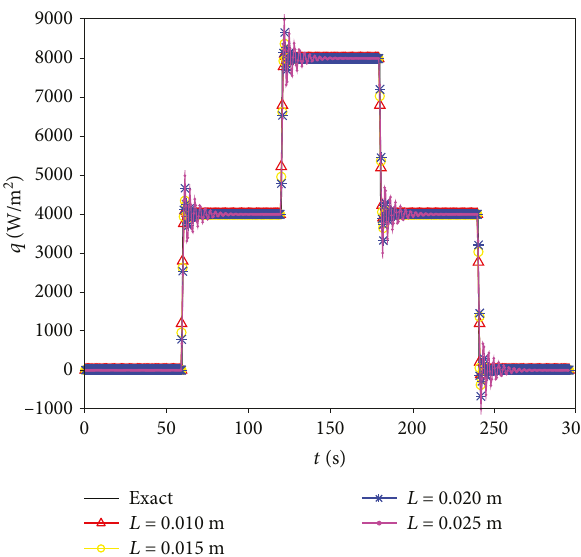
Figure 9: The history of measured and calculated temperatures for di ff erent measuring errors when L = 0 01 m and R = 3 .